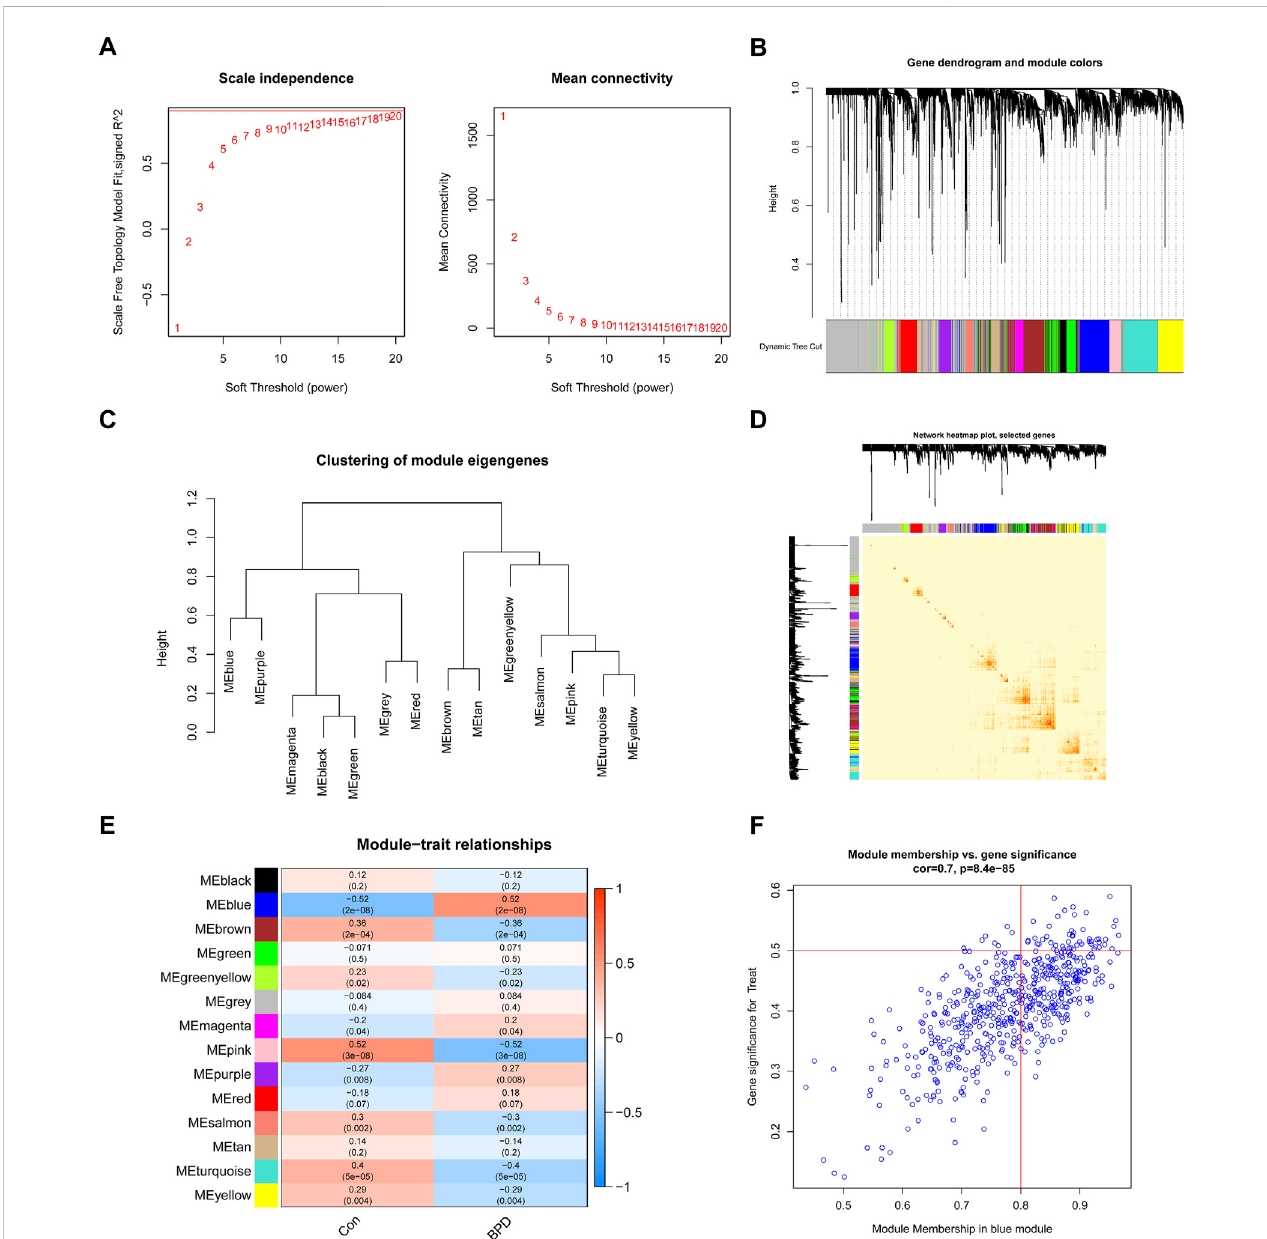
FIGURE 5 Co-expression network of DEGs in BPD. (A) The selection of soft threshold power. (B) Cluster tree dendrogram of co-expression modules. (C) Representative of clustering of module eigengenes. (D) Representative heatmap of the correlations among 14 modules. (E) Correlation analysis between module eigengenes and clinical status. (F) Scatter plot between module membership in the blue module and the gene signi fi cance for BPD.